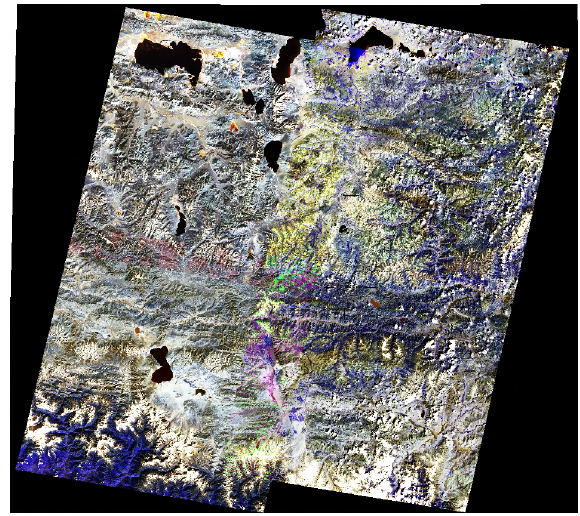
Figure 5. RGB composite result of mosaic of optical images.